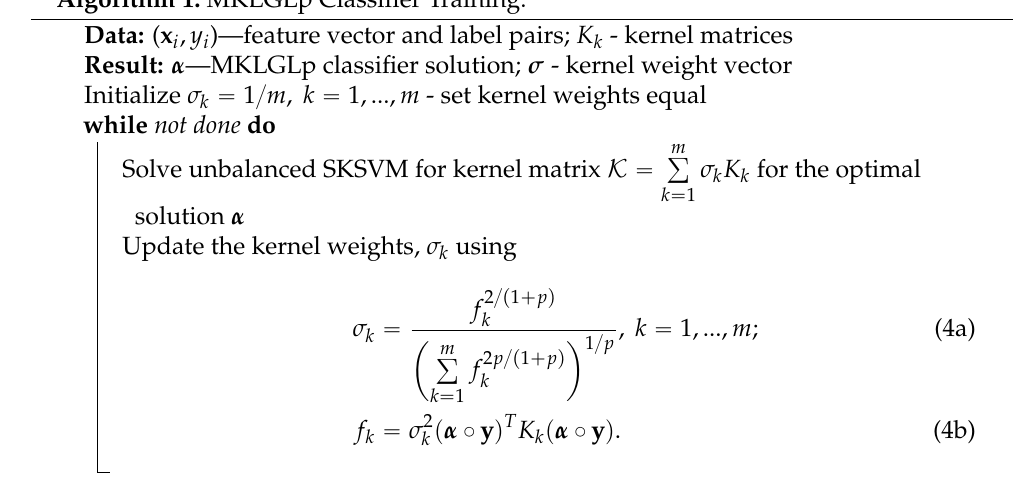
Algorithm 1: MKLGLp Classifier Training.